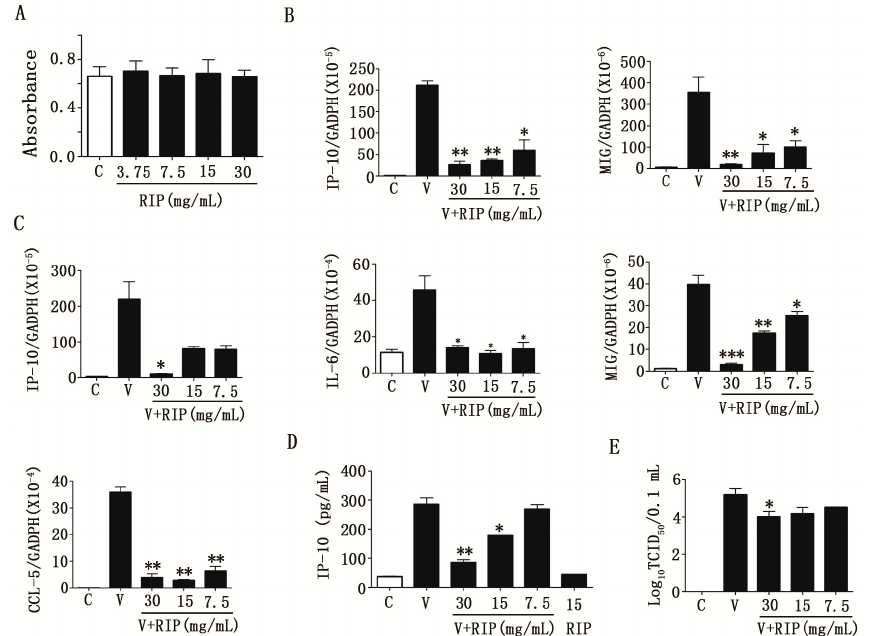
Figure 1. Radix isatidis polysaccharides showed anti-inflammation activity in 16HBE cells infected with PR8/H1N1 virus. ( A ) Cell viability was evaluated as described in Materials and Methods and expressed as a percentage of the vehicle control. After mock-infection or infection with PR8 (MOI = 0.1 TCID 50 /cell), 16HBE cells were treated with R. isatidis polysaccharides or 0.5% DMSO. Total RNA of the 16HBE cells at 6 h ( B ) or 24 h ( C ) was isolated, and RT-qPCR was performed. Samples were normalised to GAPDH as a control. The protein level of IP-10 was tested by ELISA ( D ), and the virus titer in the supernatant was tested by the CPE method ( E ). RIP: R. isatidis polysaccharides. Data are shown as the mean ± SD for three independent experiments. Statistical significance was evaluated using the Student’s t -test, relative to the mock-infected cells ( * p < 0.05, ** p < 0.01, *** p < 0.001).